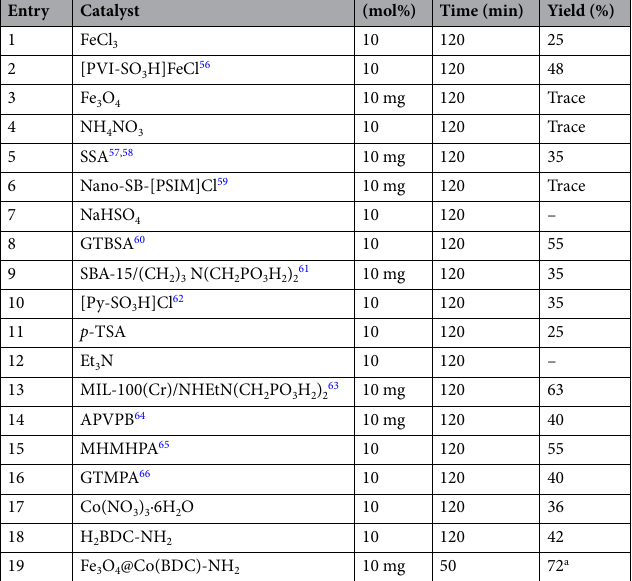
Table 3. Synthesis of pyrazolo[4 ′ ,3 ′ :5,6]pyrido[2,3-d]pyrimidine-5,7(6 H )-dionein the presence of various catalysts under ultrasonic irradiation. a This